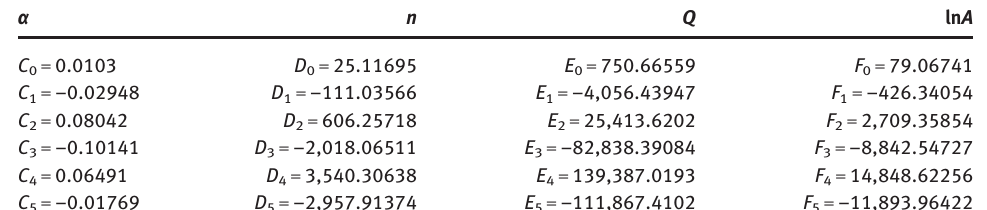
Table 5: Coefficients of the polynomial for α , n, Q and ln A .